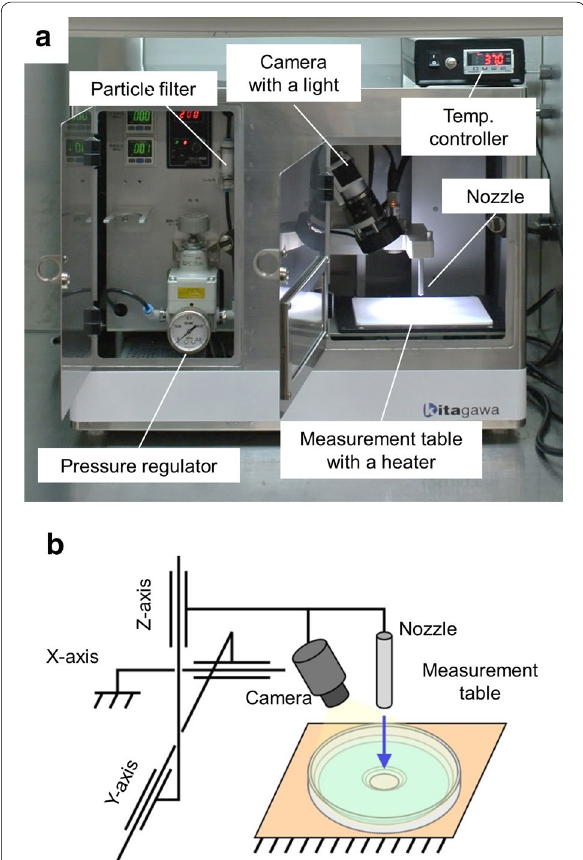
Fig. 2 Development of the non-contact wettability assessment system. a Photo of the system, consisting mainly of the jet-flow application and observation parts. b Schematic diagram showing the position adjustment mechanism